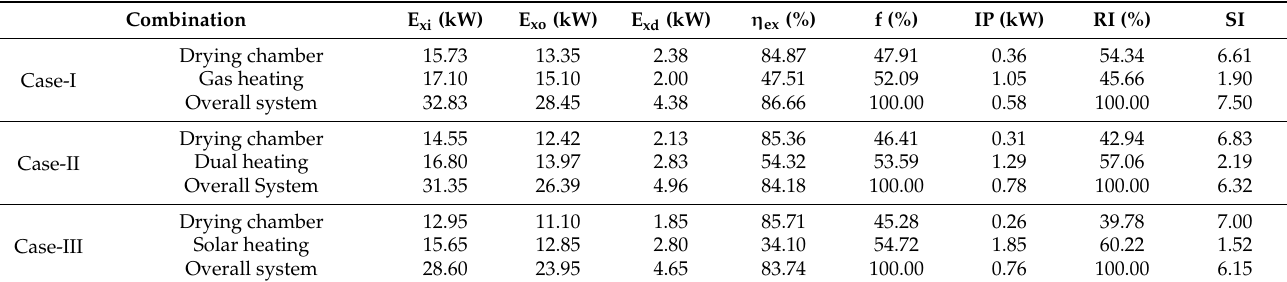
Table 4. Outcomes of conventional exergy analysis obtained from drying